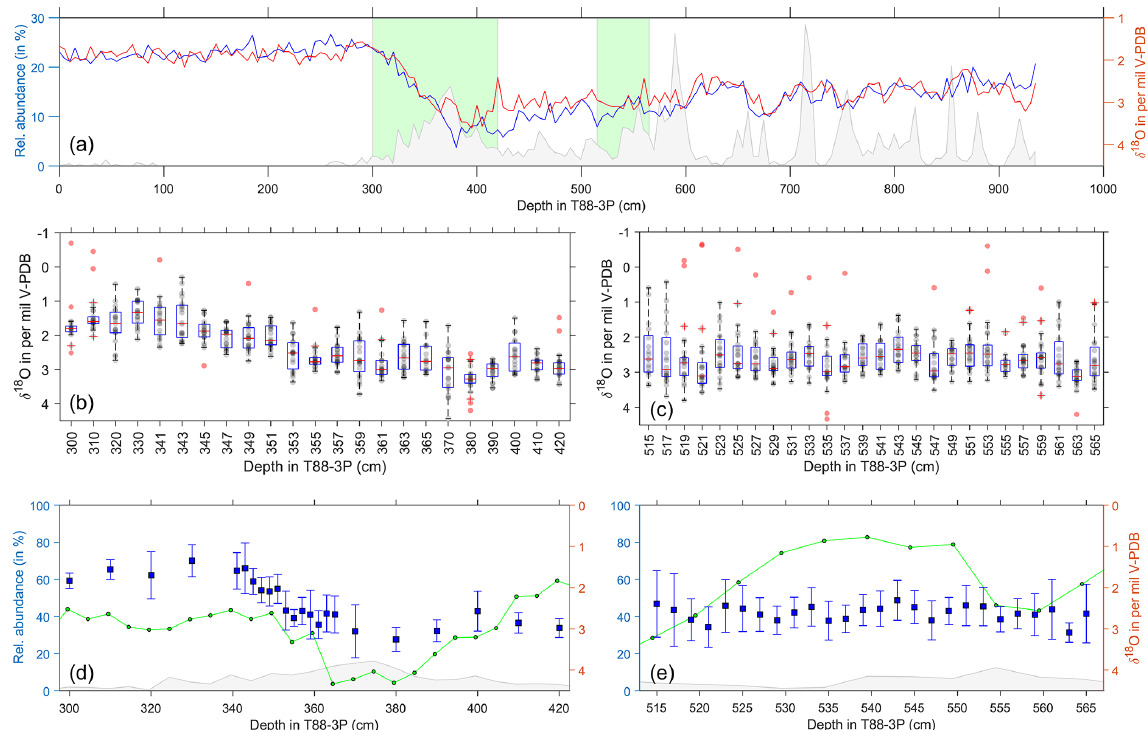
Figure 6. Single-foraminifera stable isotope data: G. bulloides . (a) Pooled average oxygen stable isotopes of G. bulloides (blue) and G. glutinata (red), from Fig. 2, and ice-rafted debris (grey) for the same samples (Figs. 3 and 4). Green areas represent the deglacial ( b, d ) and glacial ( c, e ) samples. (b–c) Raw stable isotope values (grey) of G. bulloides for each sample and the sample’s respective outliers (red). Overlain are the statistical features of the distribution outlined by a box-and-whisker plot (median, upper and lower quartiles). (d–e) Average values and the standard deviation (blue) of the outlier-corrected oxygen isotope data plotted alongside the abundance of G. bulloides (green; see Fig. 4) and IRD (grey; see Fig.